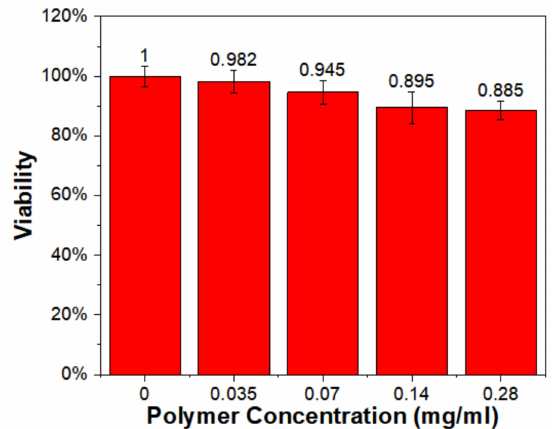
Figure 11. Cell viability test of Ramos cells at various concentrations incubated with micellar oxygen sensor for 24 h evaluated by methyl thiazolyl tetrazolium (MTT)